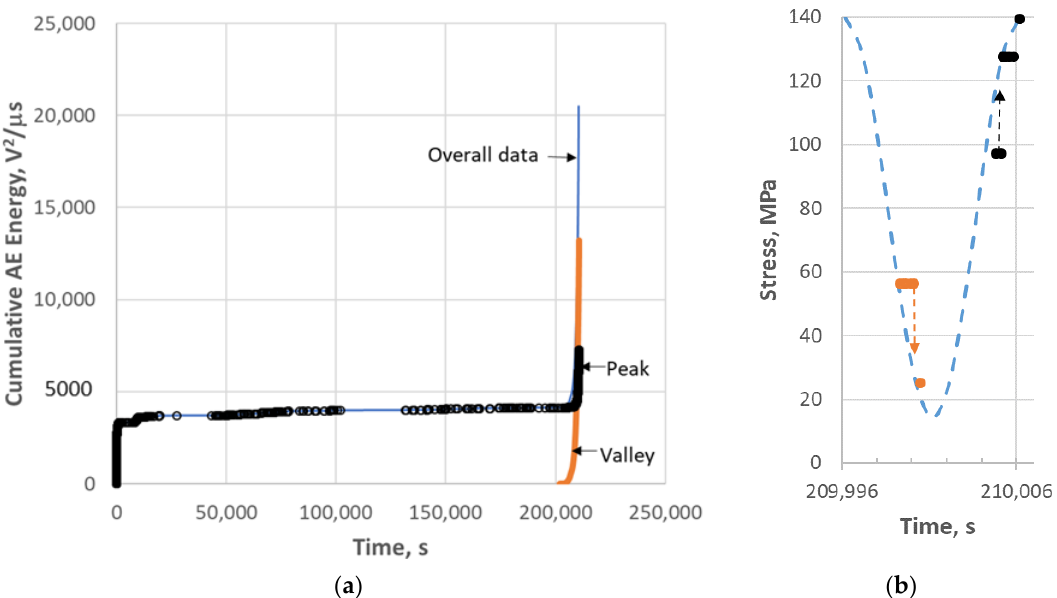
Figure 3. ( a ) Cumulative AE energy for 113- 3 (0.1 Hz fatigue). The “Overall data” are separated